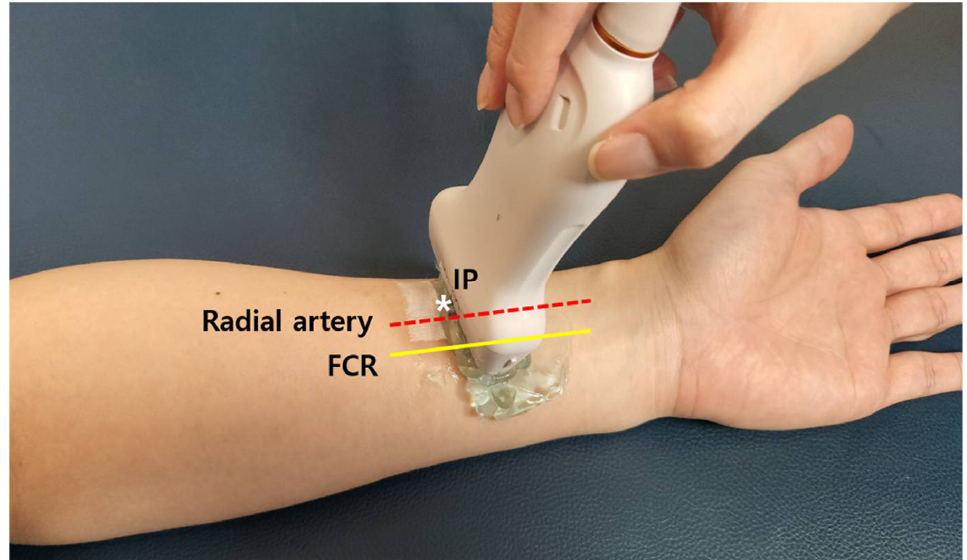
Figure 1. Ultrasound scanning for flexor pollicis longus at distal third of forearm. After palpation of the radial artery pulse (red dotted line), 5 mm lateral to the pulse was marked as * for the preliminary needle insertion point (IP). Sonographic view was obtained without compression using sufficient gel. FCR, flexor carpi radialis (yellow line).